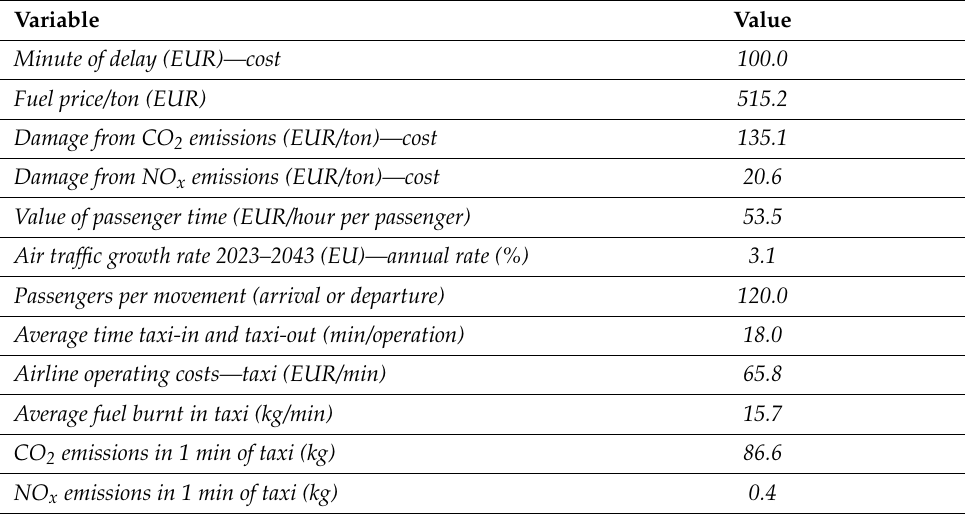
Table 2. Data of interest for the calculation of the project’s operating benefits